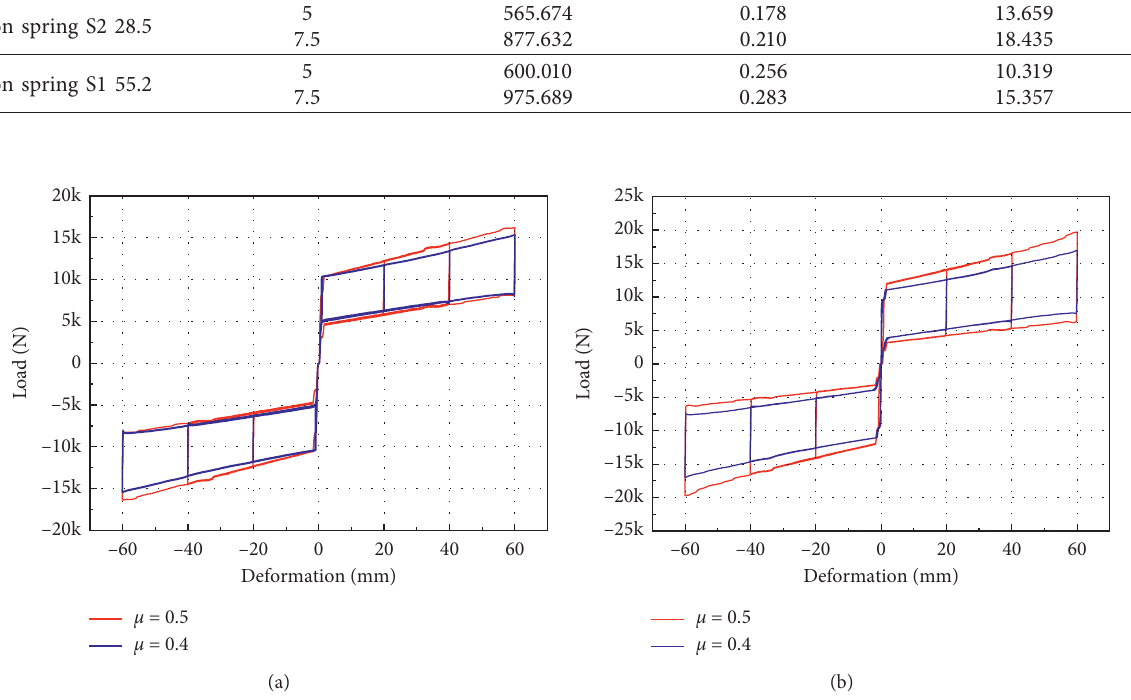
Secant stiffness K s Equivalent damping ratio (%) ξ eq (kN/mm)